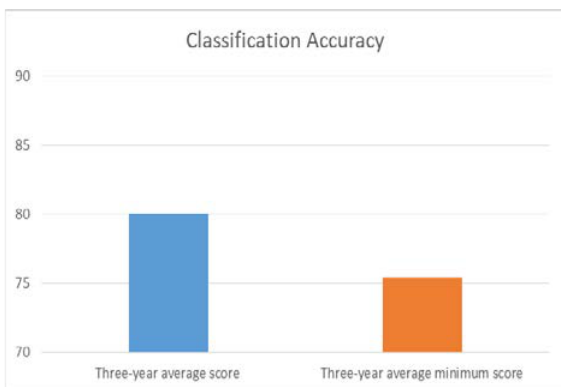
Figure4. Three-year average score and minimum score of classification